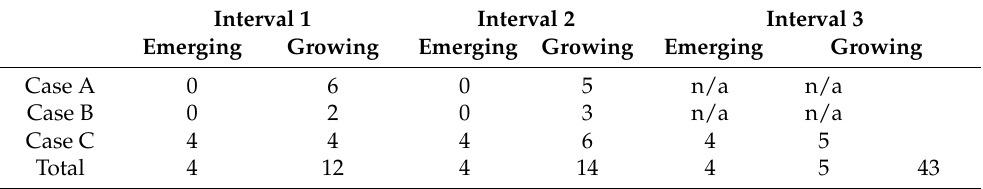
Table 1. The number of emerging and growing lesions for each case and their